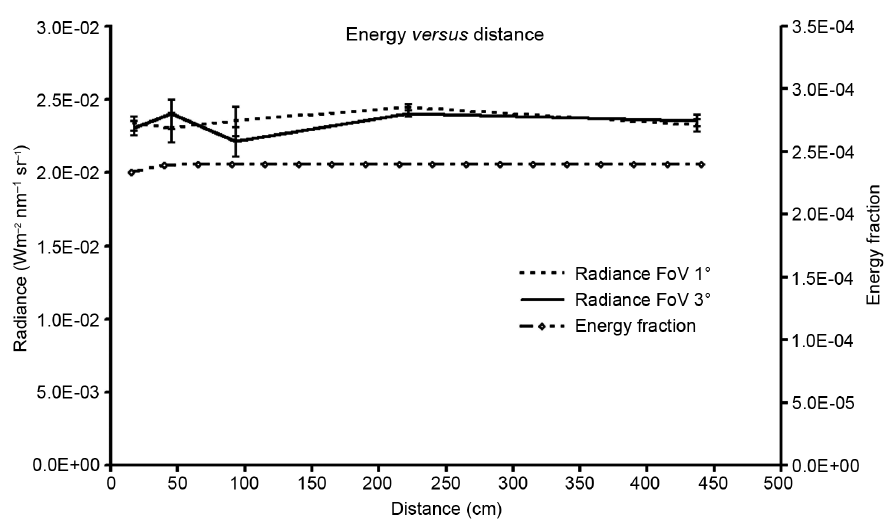
Fig. A.2. Graph of the radiance trend with respect to the distance from the panel to ASD foreoptics. The curves show the ASD measured trend for FoV 1° ( F = 98 mm) and FoV 3° ( F = 32 mm), while energy fraction curve rep- resents the numerical solution of eq. (A.12) and eq. (A.13). Table A.I. R c as a function of the distance between field stop source for the two ASD optics. Z